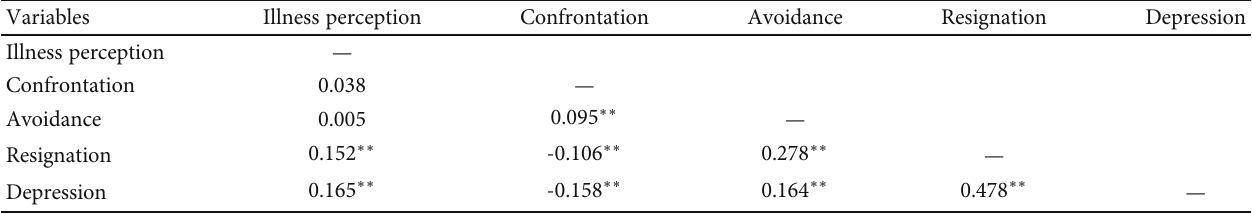
Table 3: Correlation between illness perception, coping style, and depressive symptoms.